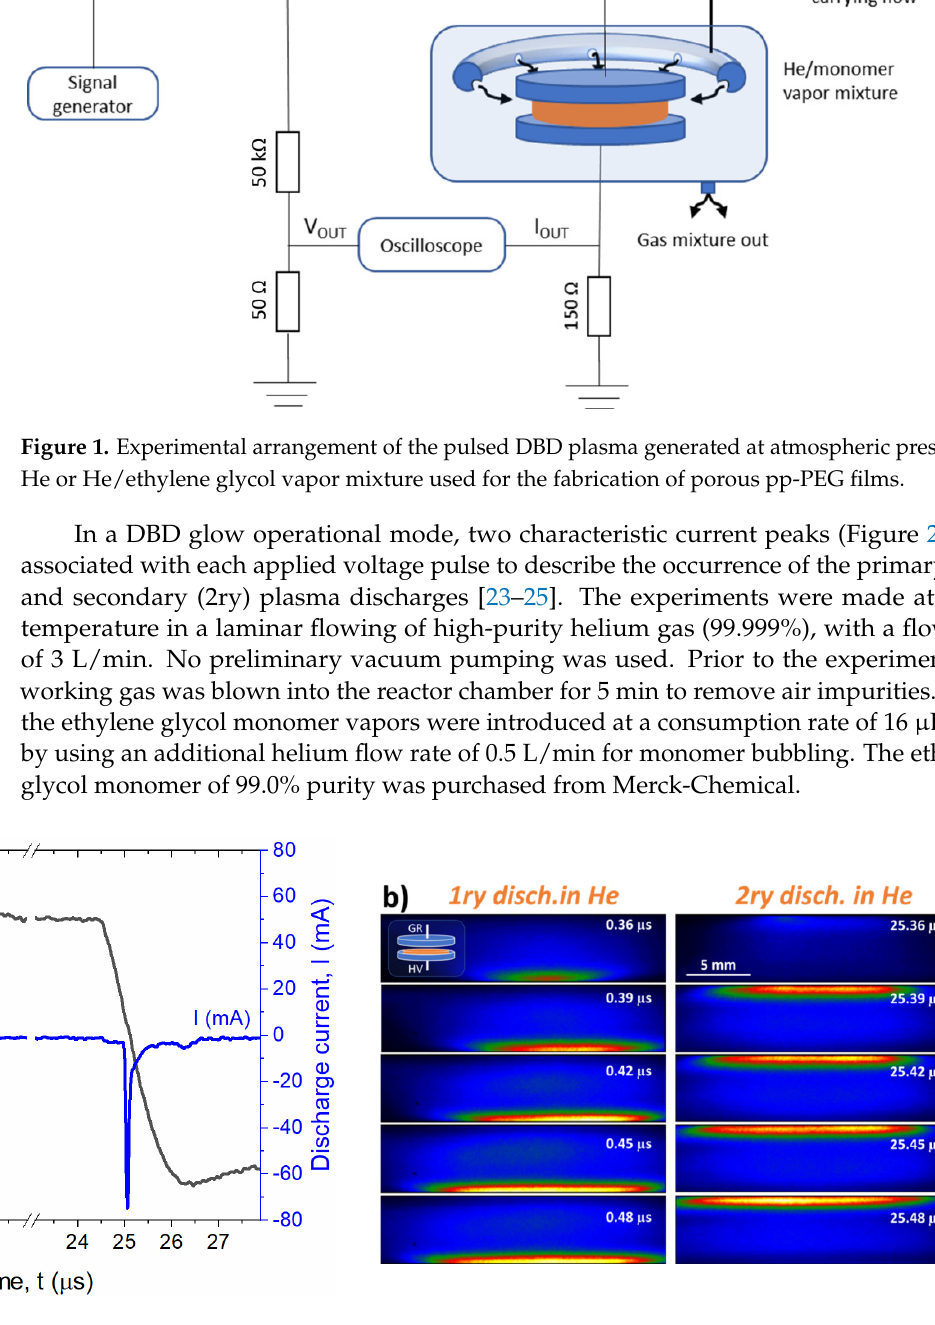
Figure 2. ( a ) Temporal profile of the applied voltage with generated electrical current during DBD. ( b ) 30 ns gated ICCD spectrally integrated images of the primary (1ry) and secondary (2ry) DBD plasma expanding in He. The inserted sketch shows the placement of the discharge electrodes, where GR represents the ground electrode and HV represents the high-voltage electrode. The amplitude of the applied discharge pulse was maintained constant at 4.5 kV, while the repetition rate was varied between 2 kHz and 10 kHz. All studies were con- ducted with a constant polymerization time of 10 min. The asprepared pp-PEG films were characterized by the Fourier transform infrared spectroscopy (FTIR) (Nicolet Nexus